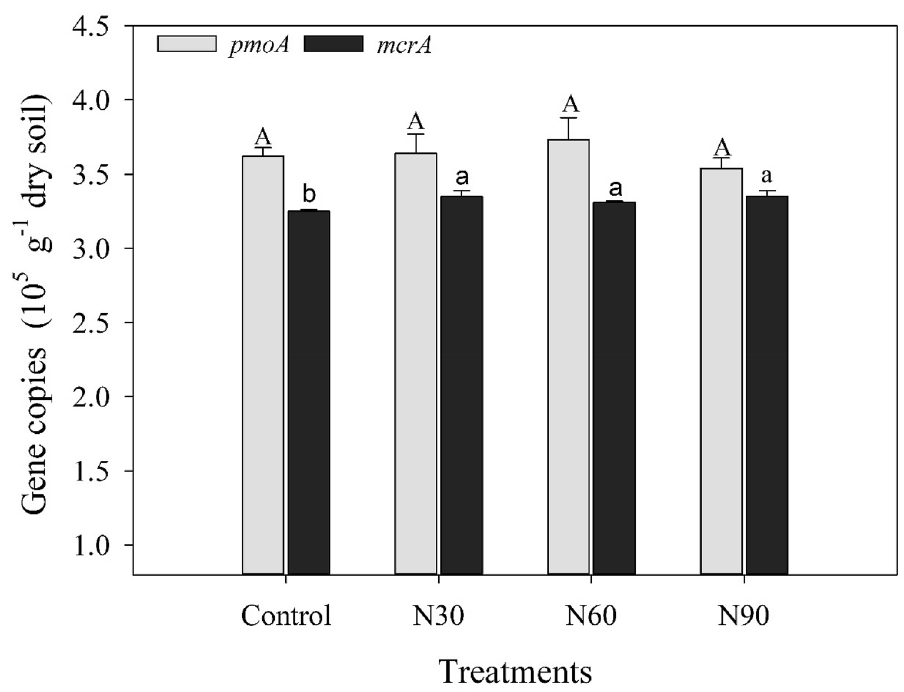
Figure 1. Methanotroph ( pmoA ) and methanogen ( mcrA ) abundance under different N addition treatments in Moso bamboo forest soil (Control, 0 kg N ha −1 yr −1 ; N30, 30 kg N ha −1 yr −1 ; N60, 60 kg N ha −1 yr −1 ; N90, 90 kg N ha −1 yr −1 ). Different upper-case letters indicate significant differences ( P < 0.05) between treatments for methanotrophs and different lower-case letters indicate significant differences ( P < 0.05) between treatments for